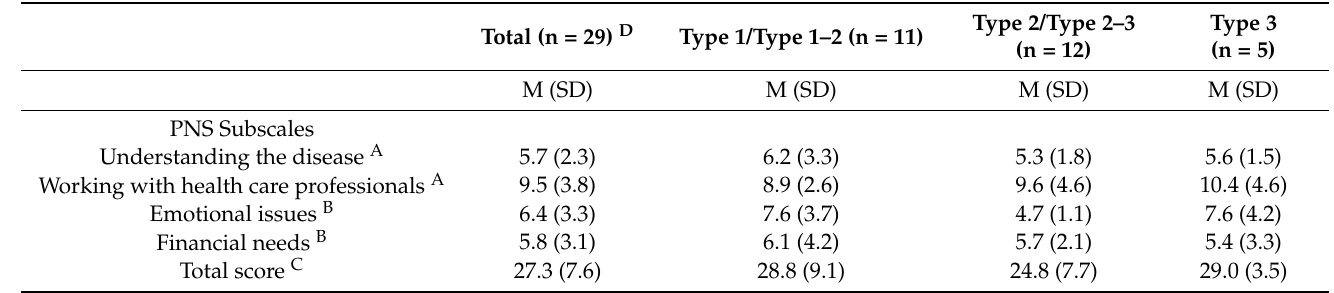
Table 5. Parental needs in families with children with different SMA types (comparison of PNS subscales), n =